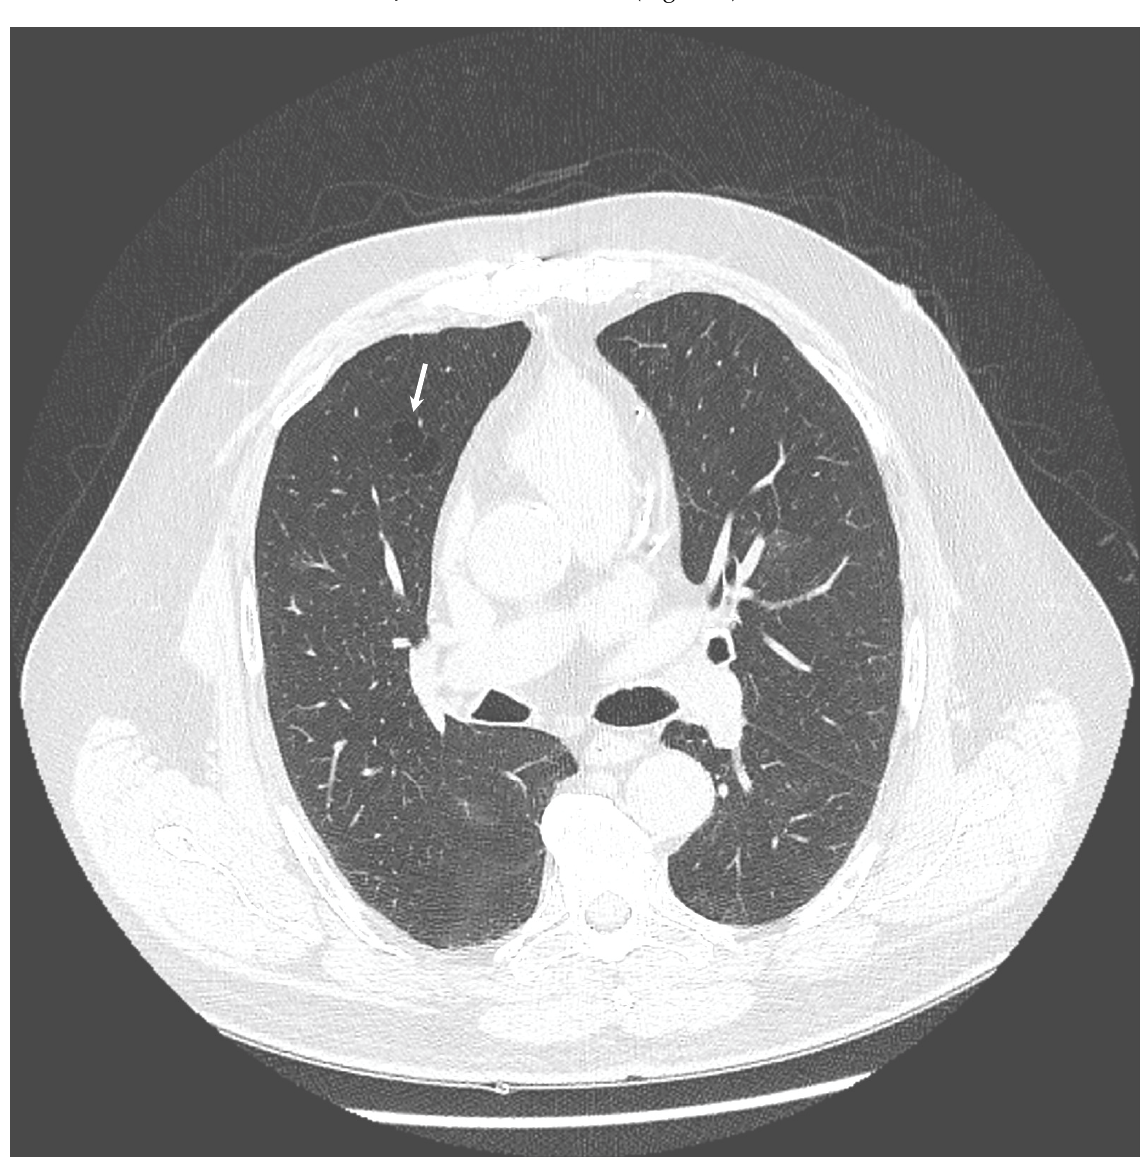
Figure 1. HRCT scan—Emphysema – the white arrow indicates the emphysematous changes in the lung. No growth of microorganisms was found in the remaining cultures during